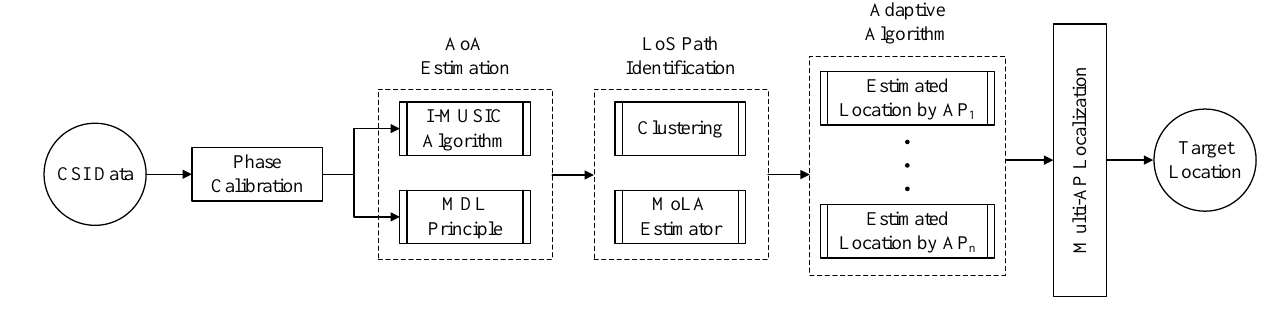
Figure 1. Flowchart of the proposed